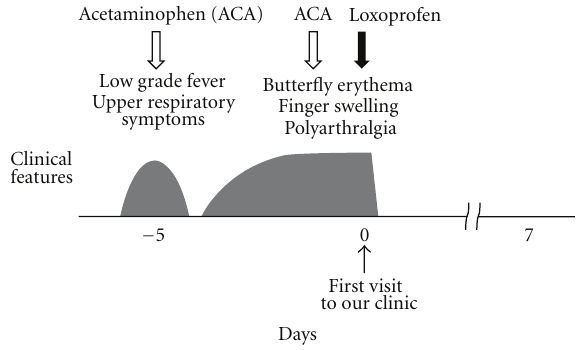
Figure 1: Clinical course of Case 1 . Five days prior to her visit, the patient had upper respiratory symptoms and a low grade fever. Then, she developed a butterfly-shaped erythema, swelling of her fingers, and polyarthralgia. Immediately after the initiation of loxoprofen, the symptoms rapidly disappeared within 12 hours. No recurrence of the symptoms or signs was noted afterwards. ACA, acetaminophen.